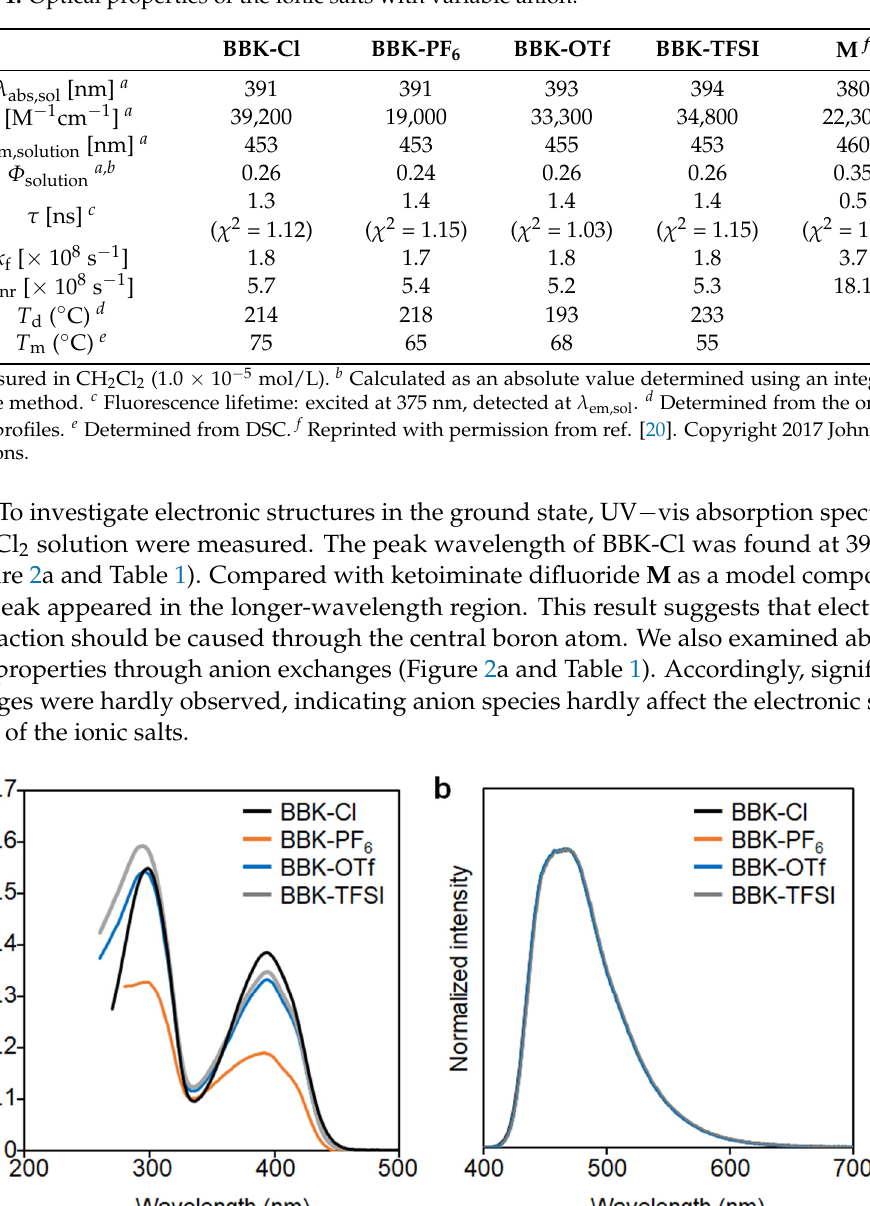
Table 1. Optical properties of the ionic salts with variable anion.